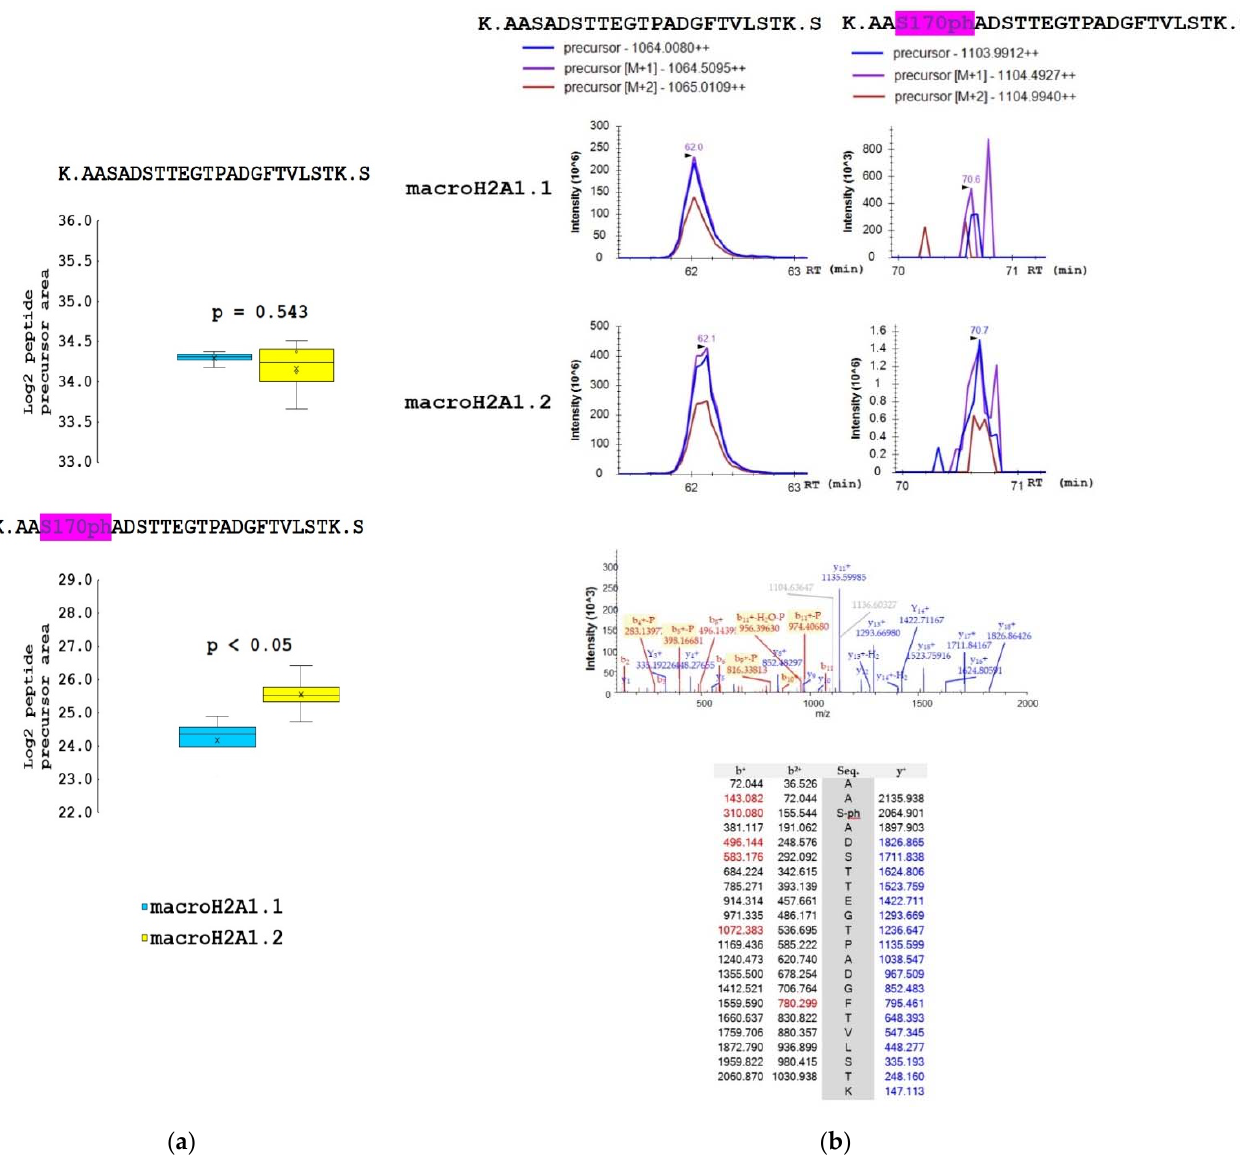
Figure 5. The proportion of S170ph mark on macroH2A1.1 and macroH2A1.2 protein isoforms in HepG2 cells. ( a ) Box- plots of the relative abundance of phosphopeptides and corresponding non-modified counterparts showing extremes, interquartile ranges, means, and medians (N = 4). Data were normalized to the sum of selected non-modified peptides to eliminate the effect of different expression levels of the two isoforms during quantitative analyses. Differences between samples in normalized peptide abundances ≥ 1.5-fold at p < 0.05 were considered as significant. ( b ) Representative MS extracted ion chromatograms of K.AASADSTTEGTPADGFTVLSTK.S with (m/z 1103.991) and without phosphorylation at S170 (m/z 1064.008), showing their abundance in macroH2A1.1 and macroH2A1.2 isoforms. Representative MS/MS spectrum produced from the precursor ion of m/z 1103.991 and fragments of y ‐ and b ‐ series with the m/z values are shown.